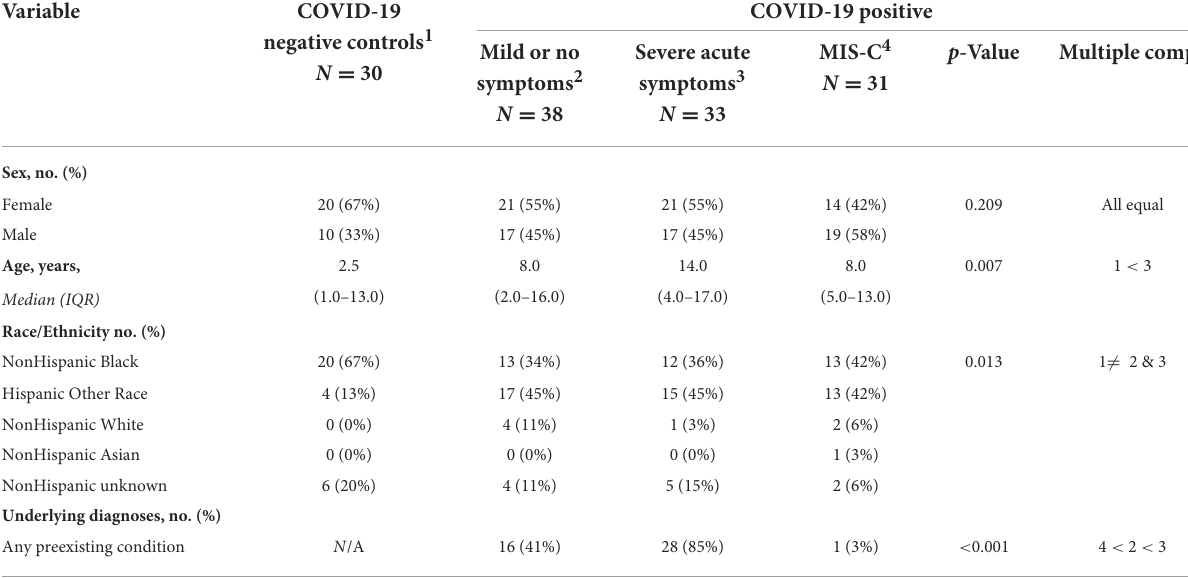
TABLE 1 Baseline characteristics for controls and patients with COVID-19, grouped by symptom severity.